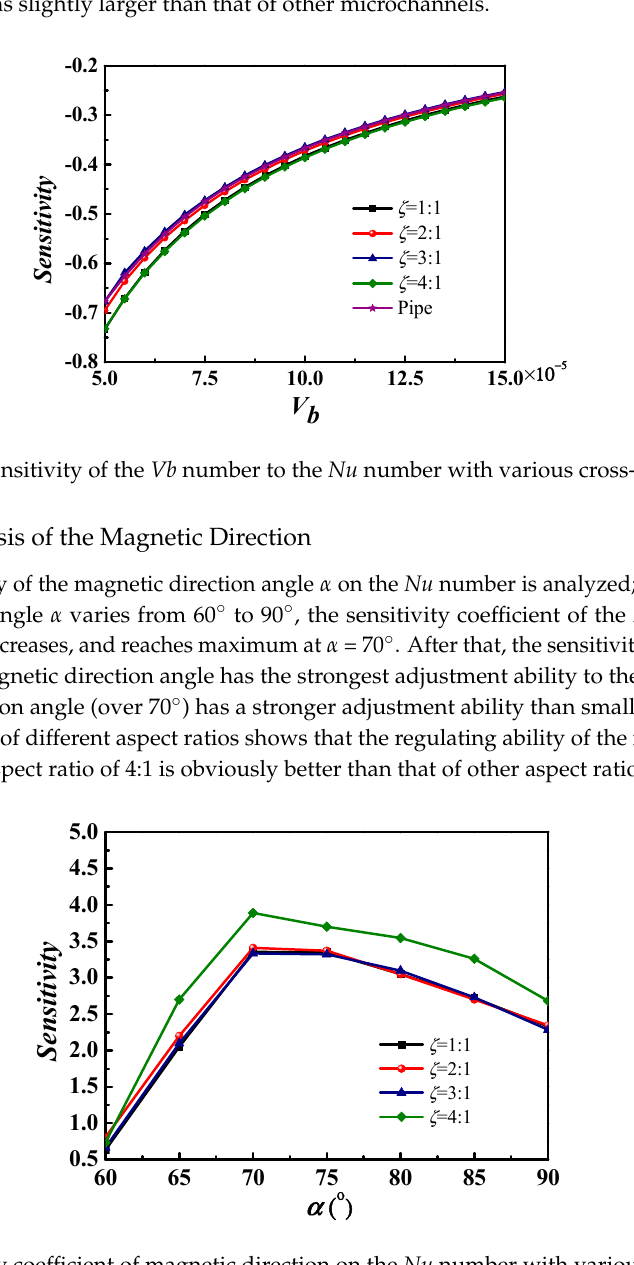
Figure 9. Sensitivity of the Ha number to the Nu number with various cross-sections.